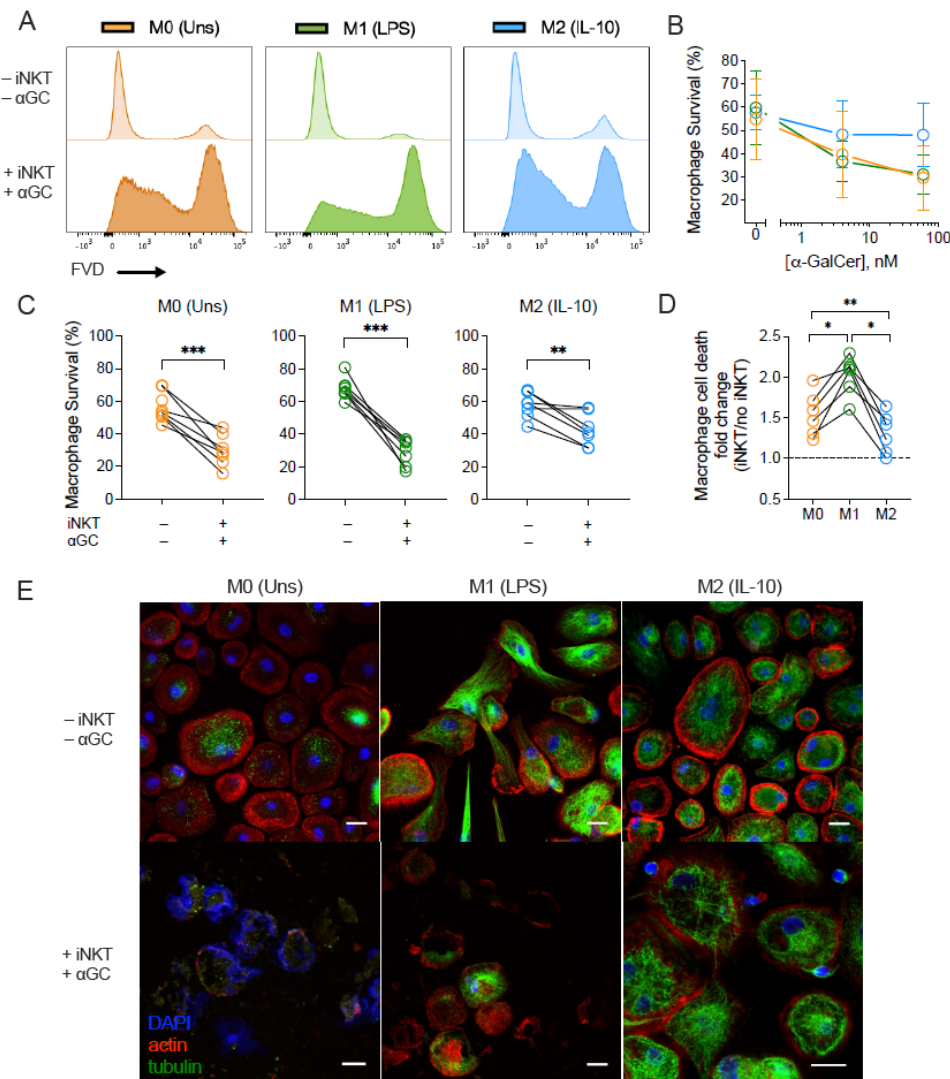
Figure 3. iNKT cells induce subset-dependent cell death of macrophages. M0 (Unstimulated), M1- (LPS-stimulated) and M2-like (IL-10-stimulated) macrophages were co-cultured with or without iNKT cells plus α -GalCer for 18 h. ( A ) Representative flow cytometry plots of macrophage viability. ( B ) Survival of M0, M1- and M2-like macrophage subsets in the presence of iNKT cells activated with 0, 4 or 60 nM of α -GalCer. ( C ) Survival of M0, M1- and M2-like macrophages in the presence of iNKT cells activated with 60 nM of α -GalCer. ( D ) Fold change of α -GalCer-driven iNKT cells killing capacity against macrophages. Macrophage cell death upon co-culture was normalized to the respective monoculture condition for each subject. ( E ) Immunocytochemistry of M0, M1- and M2-like macrophages after 18 h incubation with activated iNKT cells. Representative pictures of 1 subject, taken with a 400 × magnification, using a Leica confocal SP5 microscope. Scale bar: 20 µ m. Data are representative of ( B ) 3, ( C , D ) 7 independent experiments. * p < 0.05; ** p < 0.01; *** p < 0.001. ( B ) Two-way ANOVA, ( C ) Paired t -test, ( D ) One-way ANOVA, Tukey’s multiple comparisons